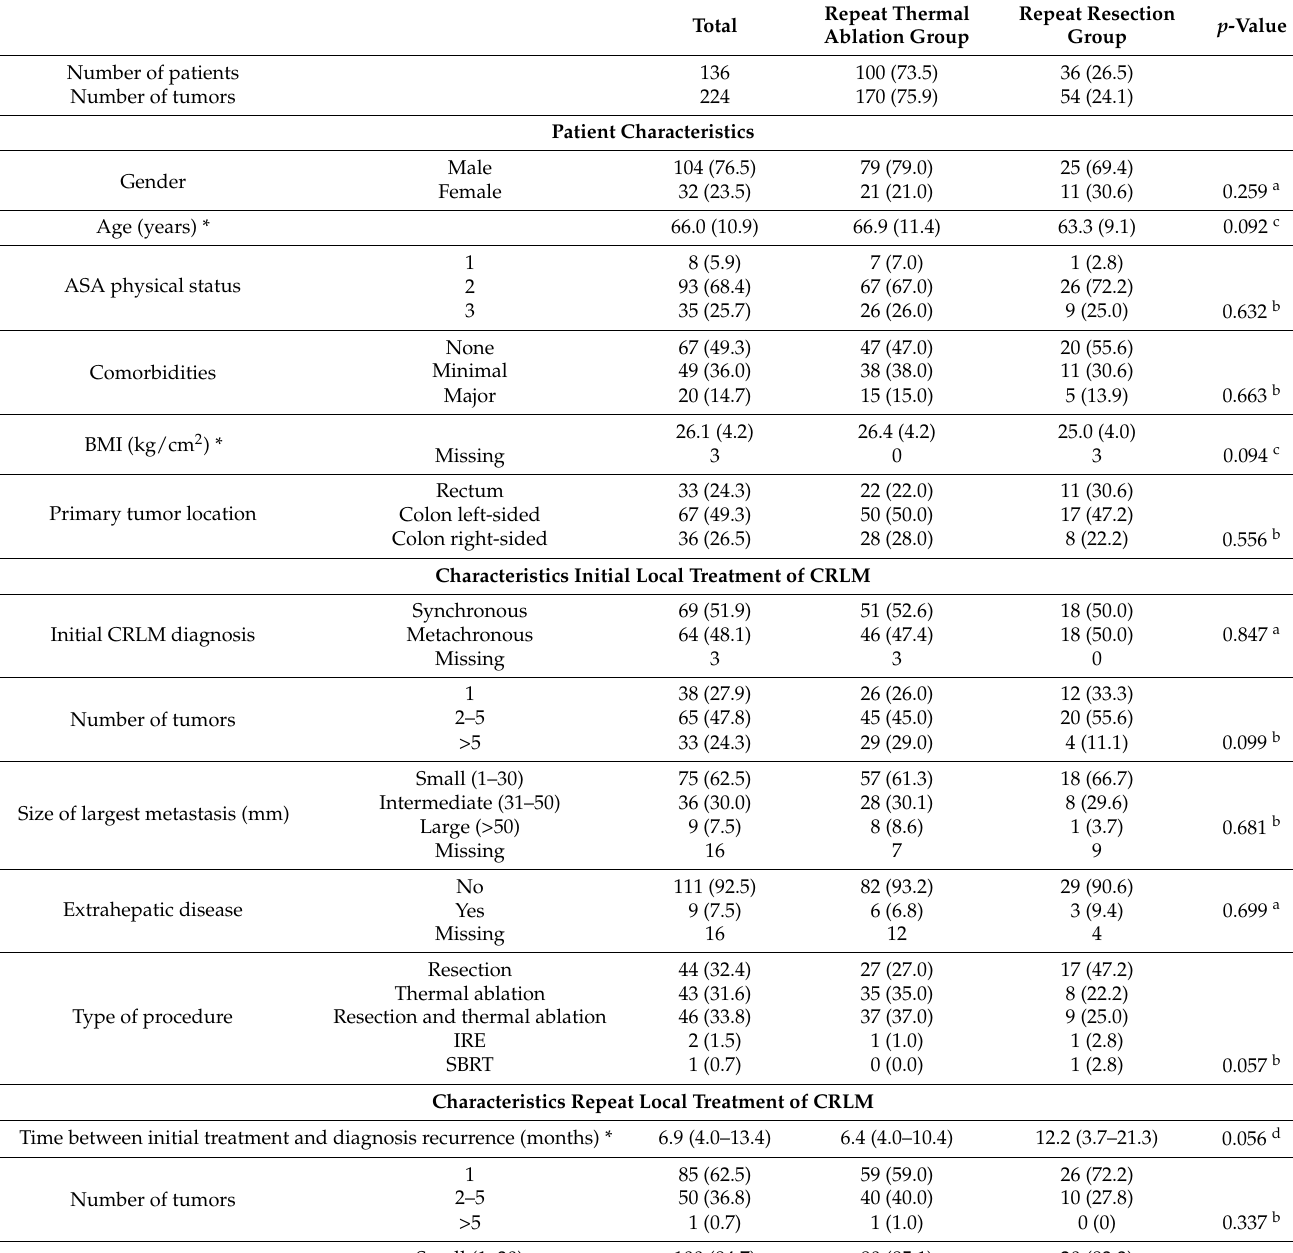
Table 1. Baseline characteristics at recurrent